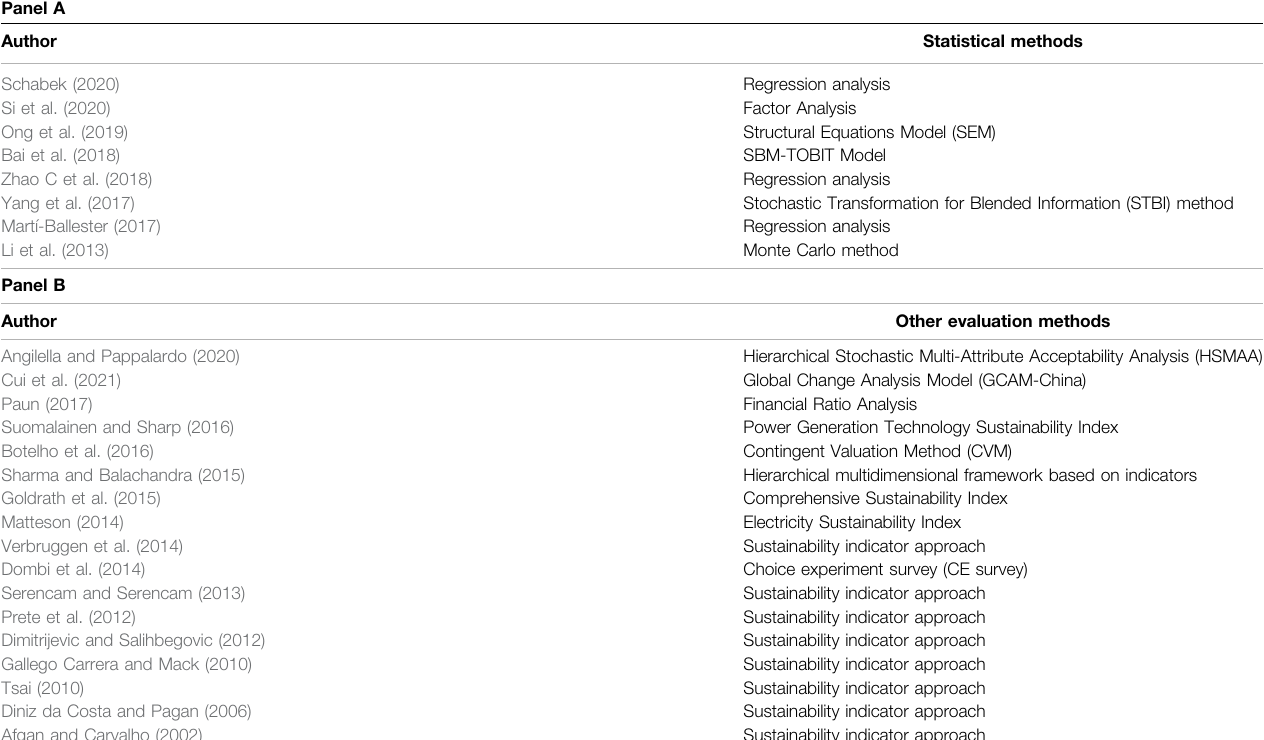
TABLE 15 | Summary of the application of statistical method and other evaluation